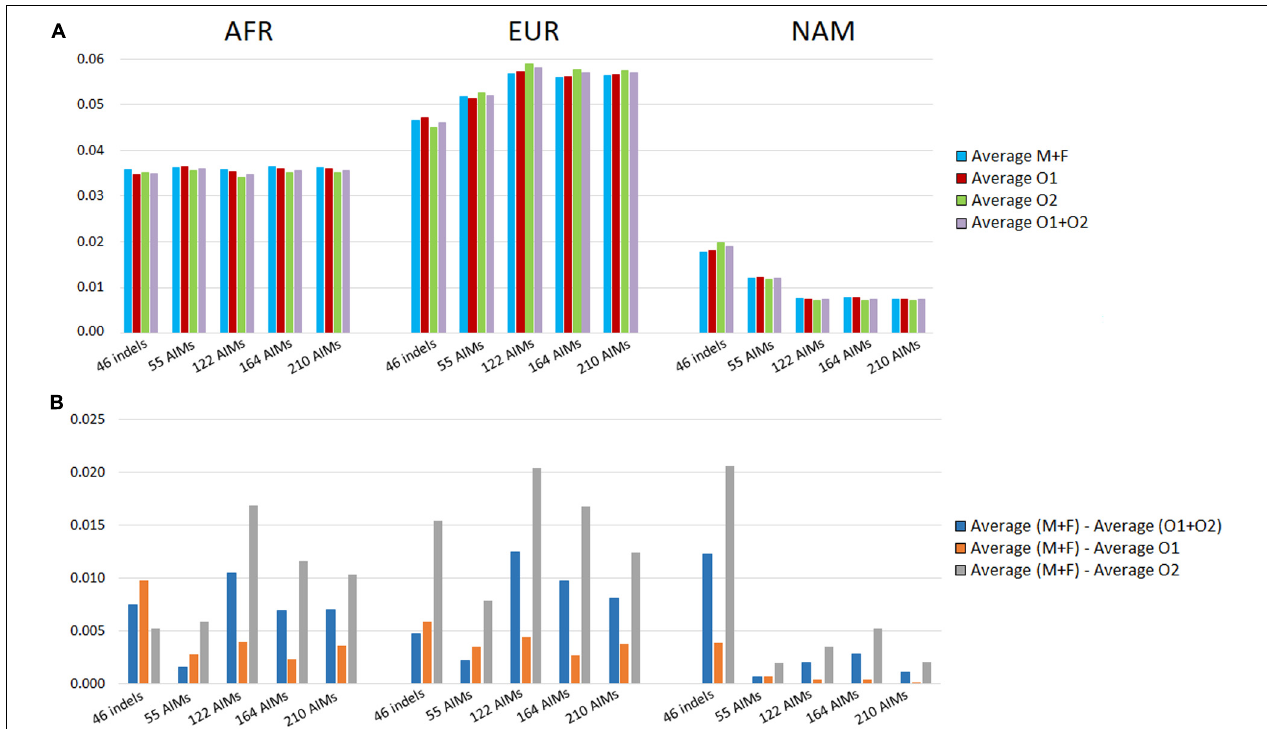
FIGURE 9 | (A) Average ancestry values per component reported by the five panels in parents (mother and father, M + F) and the offspring (offspring 1, offspring 2, and O1 + O2); (B) absolute differences between the average of the parents and: the average of both offspring (blue), the average of the offspring 1 (orange), and the average of the offspring 2 (light